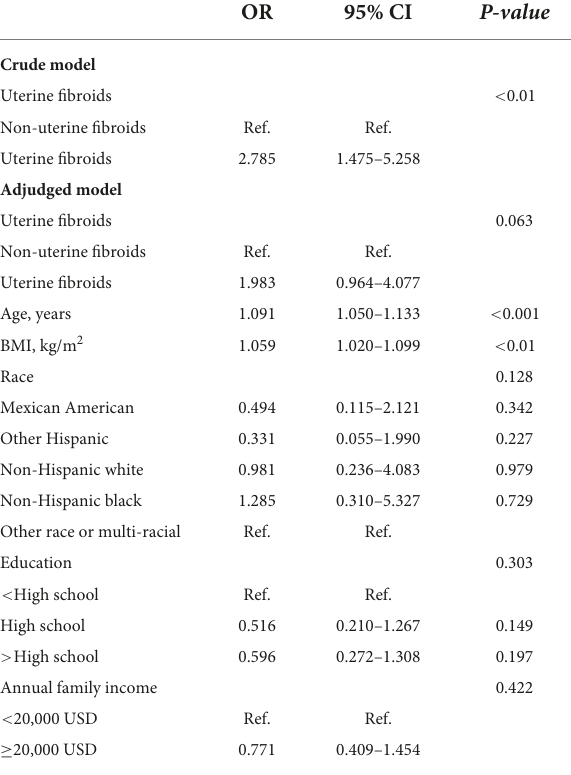
TABLE 4 Logistic regression analysis of uterine fibroids and cardiovascular diseases (CVDs) in patients without diabetes: National Health and Nutrition Examination Survey (NHANES)